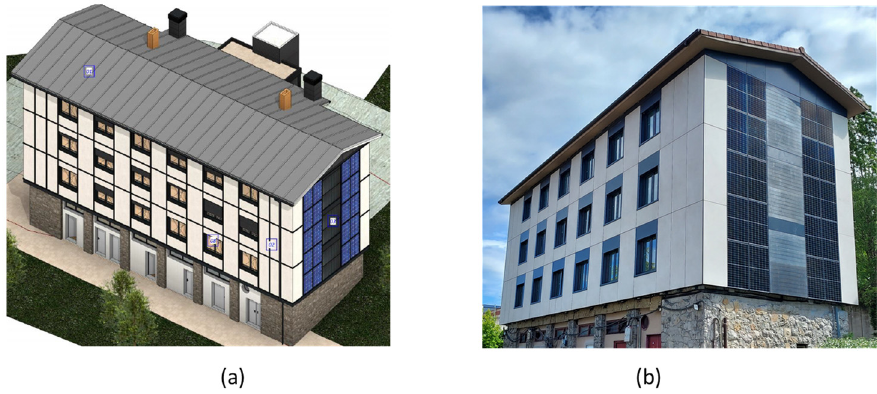
Figure 14. ( a ) Retrofitting proposal; ( b ) result of